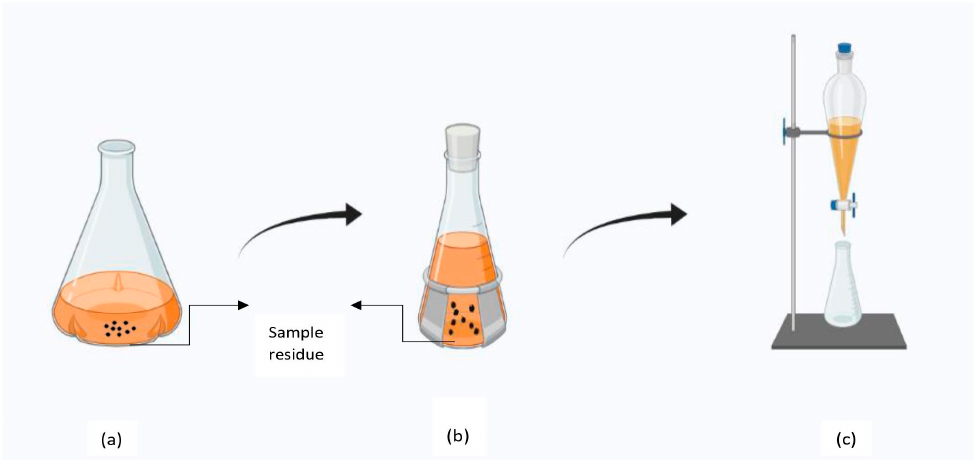
Figure 2. A diagrammatic representation of percolation extraction. ( a ) Sample immersed in solvent. ( b ) Sample placed in a sealed decanter for 4 h. ( c ) Filtering out using a